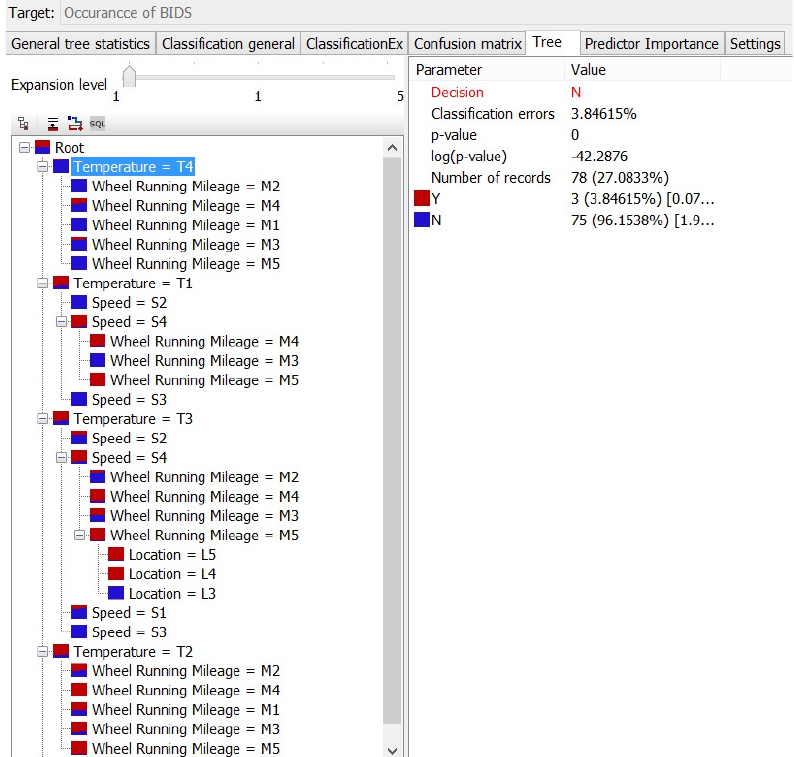
Figure 4. A screenshot of the decision tree to determine whether maintenance is needed following a BIDS alarm.